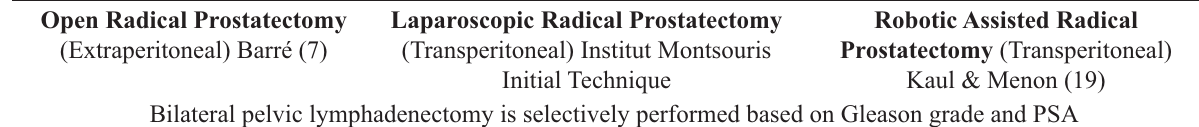
Table 1 – Retropubic, laparoscopic and robotic assisted radical prostatectomy techniques. Open Radical